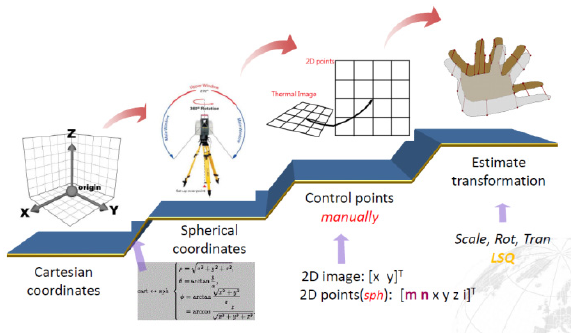
Figure 12. Workflow for registering infrared imagery to